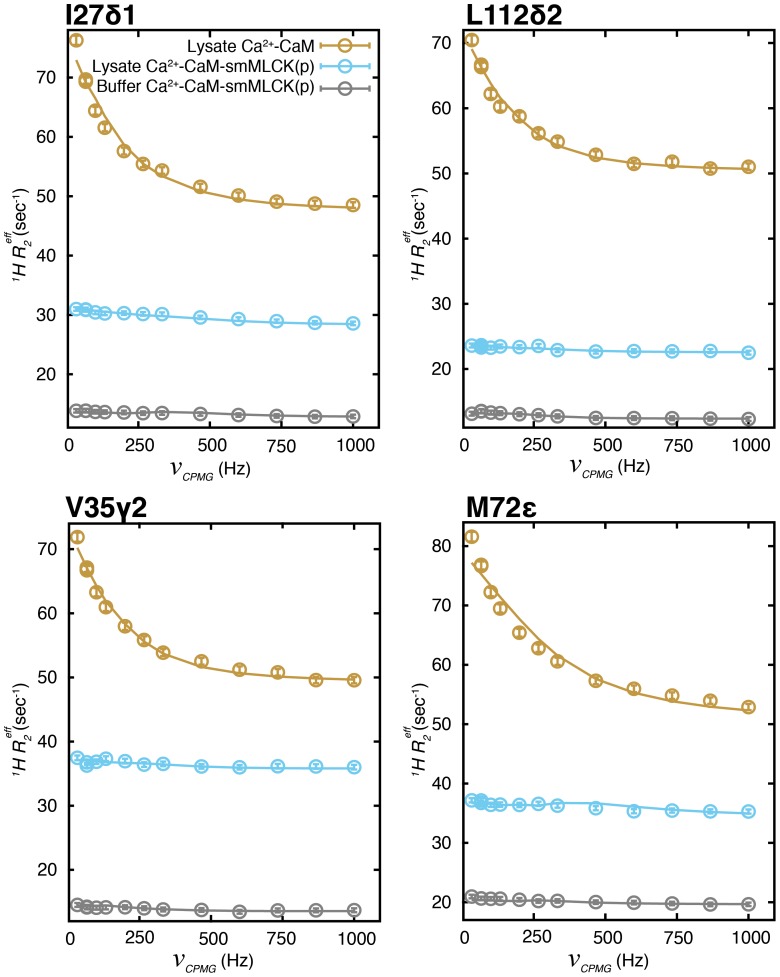
Chemical exchange in lysate Ca2+-CaM is eliminated through the addition of smMLCK(p).Representative 1H CPMG relaxation dispersion curves for methyl groups I27δ1, L112δ2, V35γ2 and M72ε of lysate Ca2+-CaM (brown), lysate Ca2+-CaM-smMLCK(p) (light blue) and buffer Ca2+-CaM-smMLCK(p) (grey). Solid lines derive from fits of profiles to a two-site global exchange model.